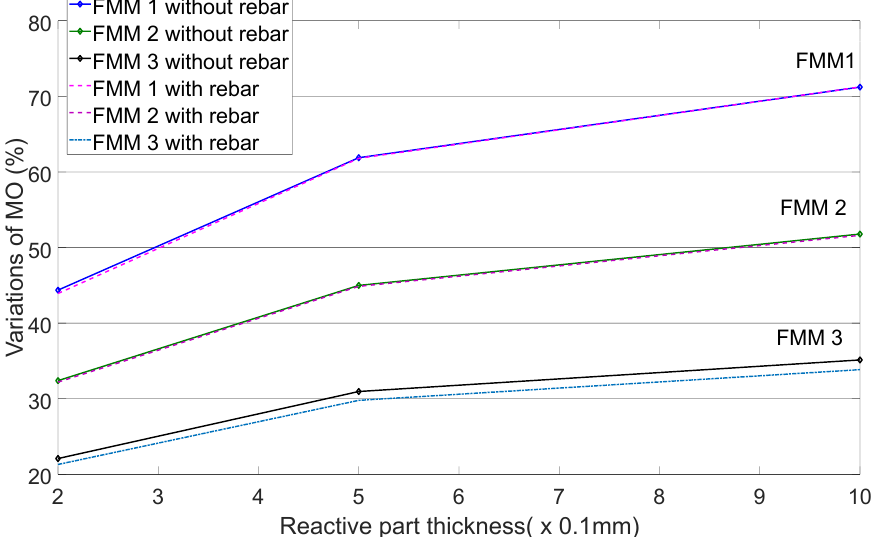
Figure 17. Percentage of relative MO attenuation with increasing reactive-part thickness and a constant surface area of 25 mm × 25 mm for Configurations 2 and